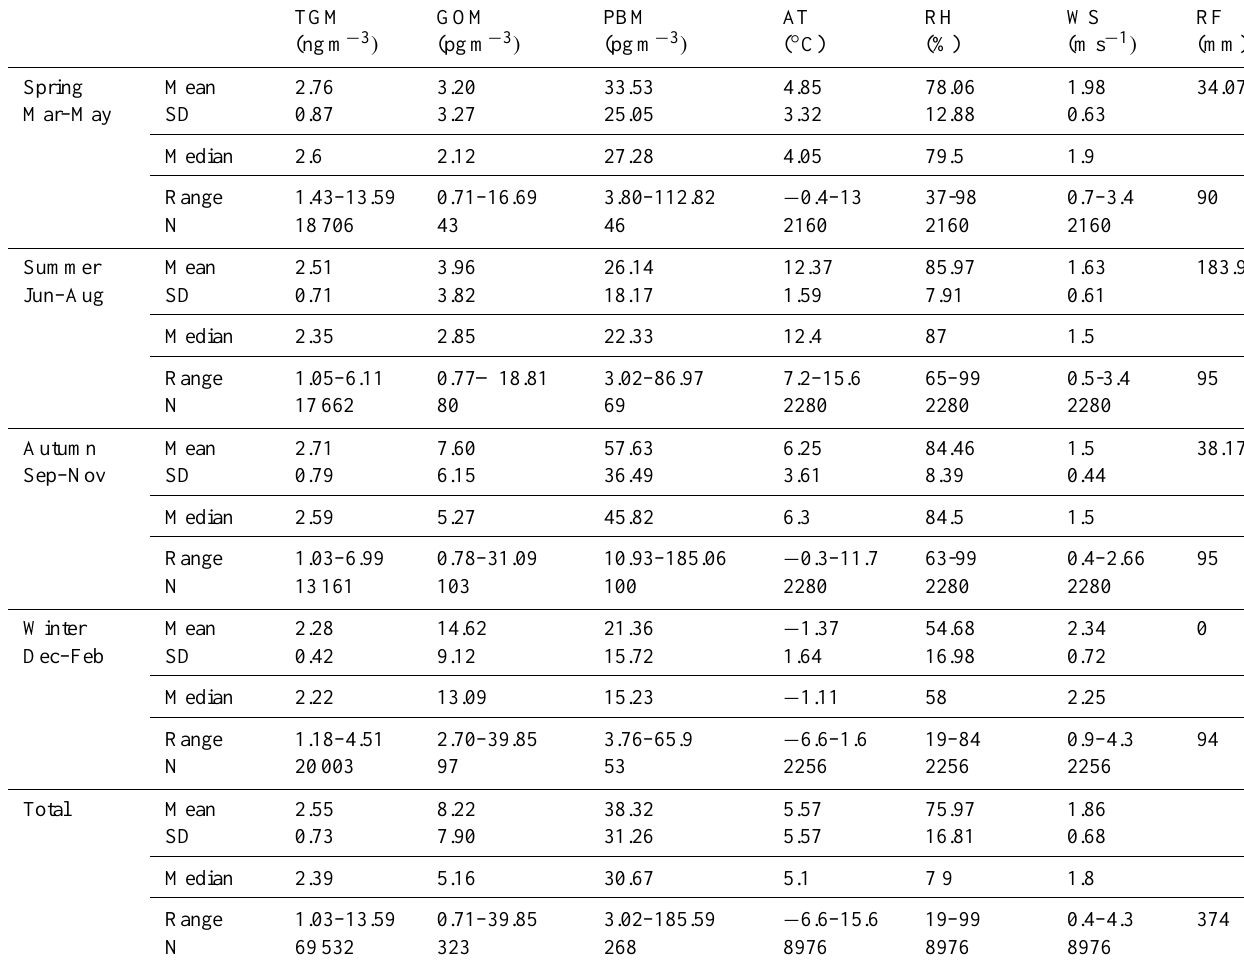
Table 1. The seasonal statistics of the measured TGM, GOM, PBM, WS, AT, RH and RF from November 2009 through November 2010 at the SAWRS site. N is the number of